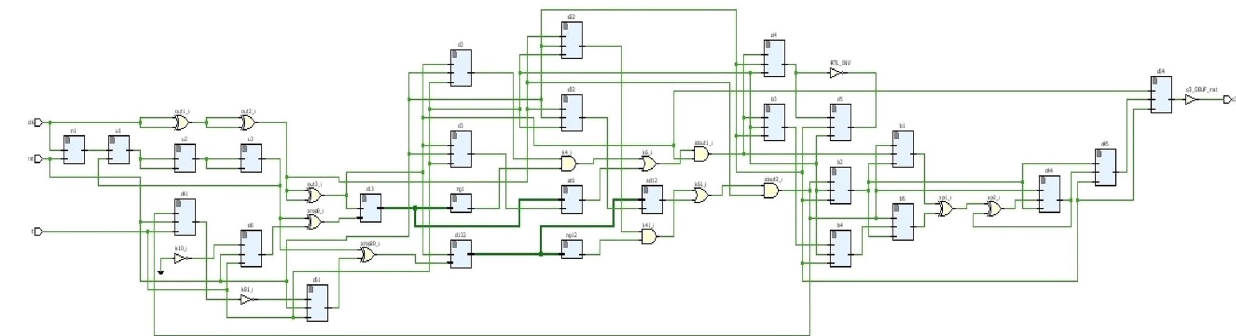
Fig. 15 Schematic diagram of FAT-2 TRNG